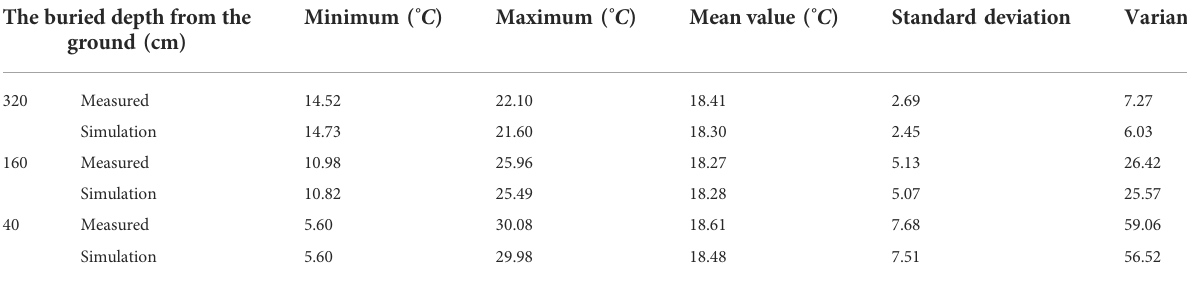
TABLE 3 The summary of fi tting results between simulation and measured data. The buried depth from the ground